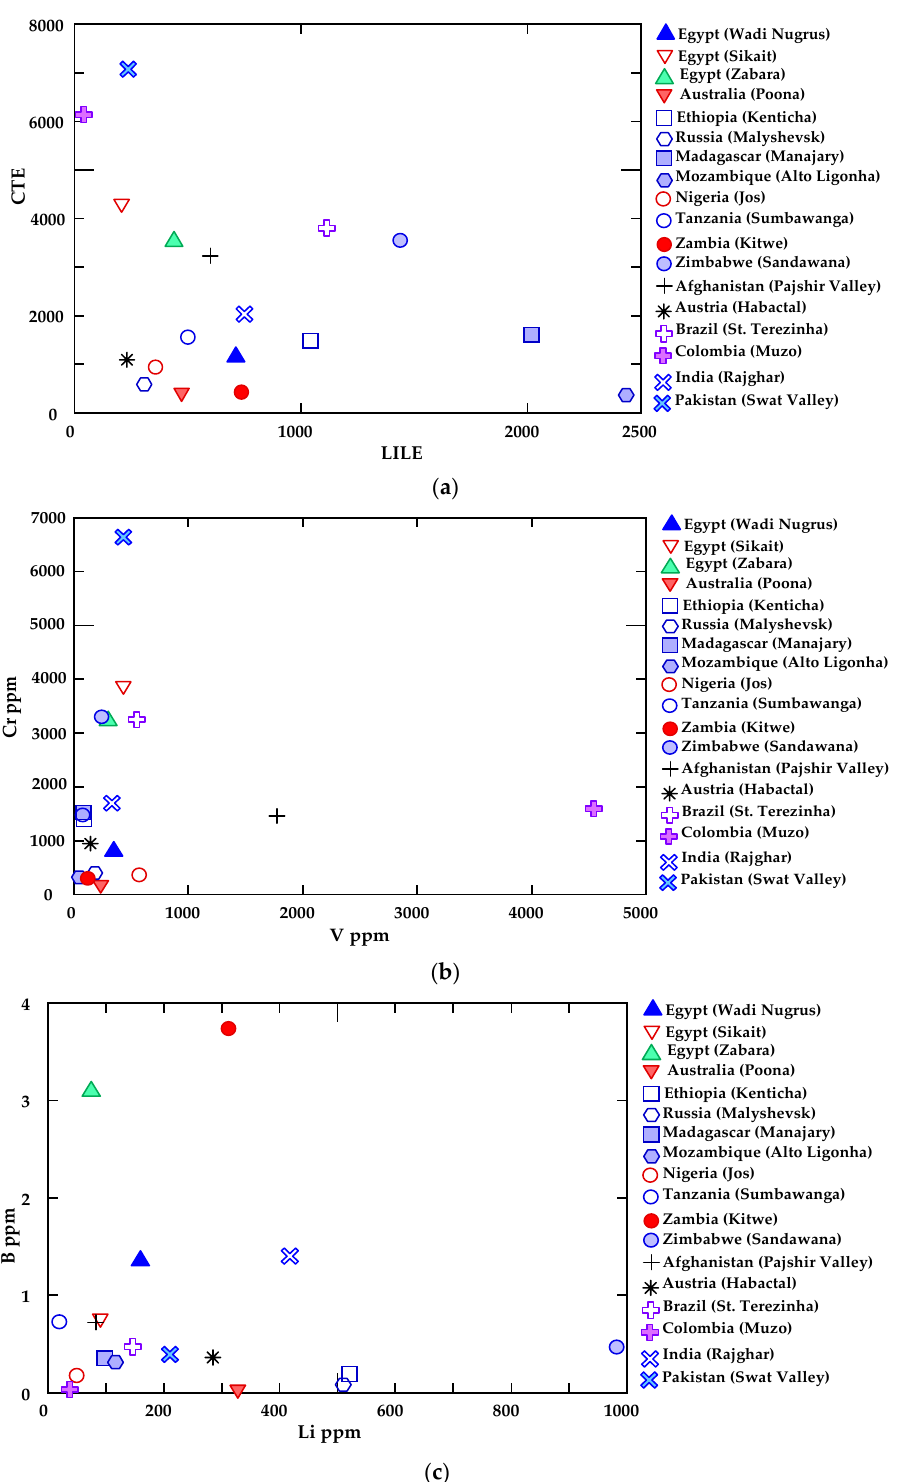
Figure 12. ( a ) Chromophore and transition element (CTE)–large ion lithophile element (LILE), ( b ) Cr–V and ( c ) B–Li binary diagrams show a comparison between beryl from Wadi Nugrus and beryl from other locations worldwide according to Aurisicchio et al. [58], using average trace and minor elements (ppm) of the analyzed emeralds.